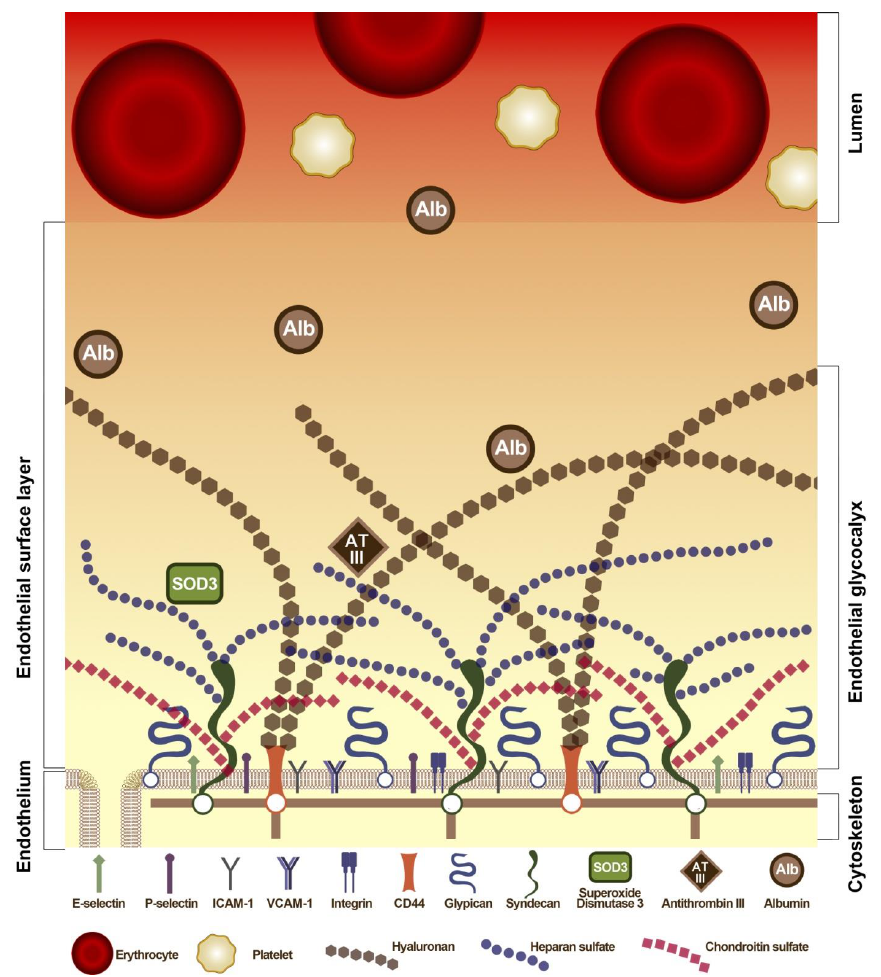
Figure 6. Albumin and endothelial glycocalyx layer (EGL). The EGL serves as the “ exclusion zone ” or “ gap ” between endothelium and blood cells. The layer also acts as a filter, limiting the passage of molecules larger than 70 kDa. Albumin, with a molecular weight of about 66 kDa, can firmly bind to the EGL and penetrate into the interstitium by transcytosis. The molecular radius of albumin prevents its passage between adjacent cells of the intact endothelial monolayer, which limits paracellular diffusion for molecules less than 3 – 5 nm in size [176 – 178]. However, the detection of albumin in interstitial and lymph flu- ids — up to 40 – 60% of the plasma level — indicates that the protein is able to leave the mi- crovessel lumen even in the absence of inflammation [179,180]. Milici et al. [181] demon- strated that albumin injected into the bloodstream of animals was later found in the intra- cellular vesicles of the capillary endothelium; in some cases, these vesicles released albu- min into the interstitium, although no rupture of interendothelial contacts was ever ob- served. This vesicular transport is known as transcytosis and is mediated by the caveolae; knockdown or deficiency of caveolin-1, without which the caveolae cannot exist, prevents